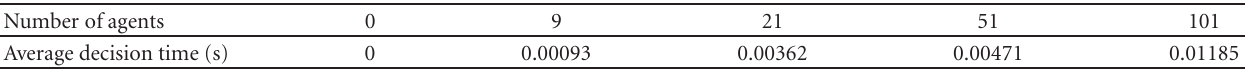
Table 4: Scalability test results for the SAP hierarchical learning framework: table of average decision making times.